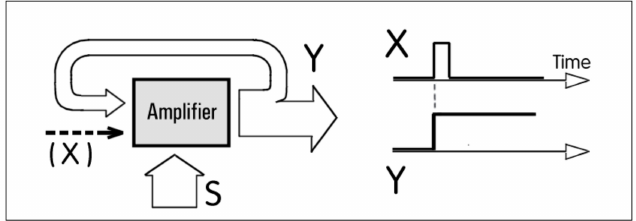
Figure 10. Use of the positive feedback: The output Y is kept in the ON state even after the input flow pulse X ceases to